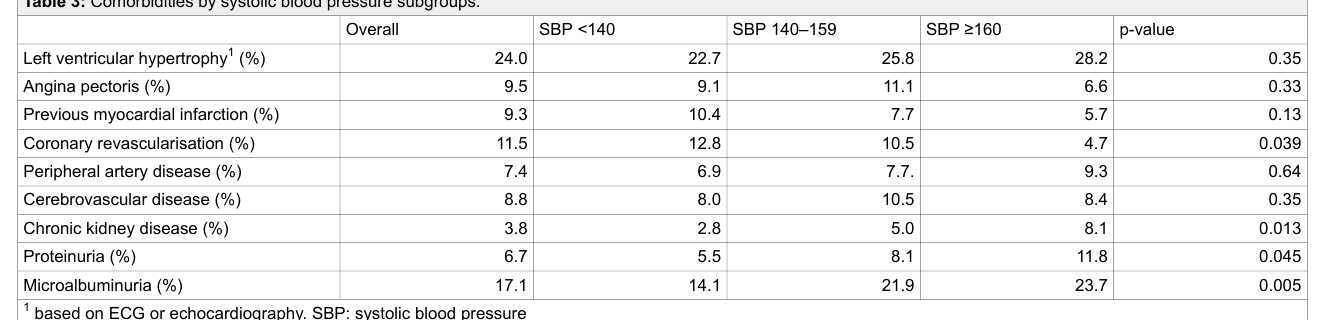
Table 3: Comorbidities by systolic blood pressure subgroups.